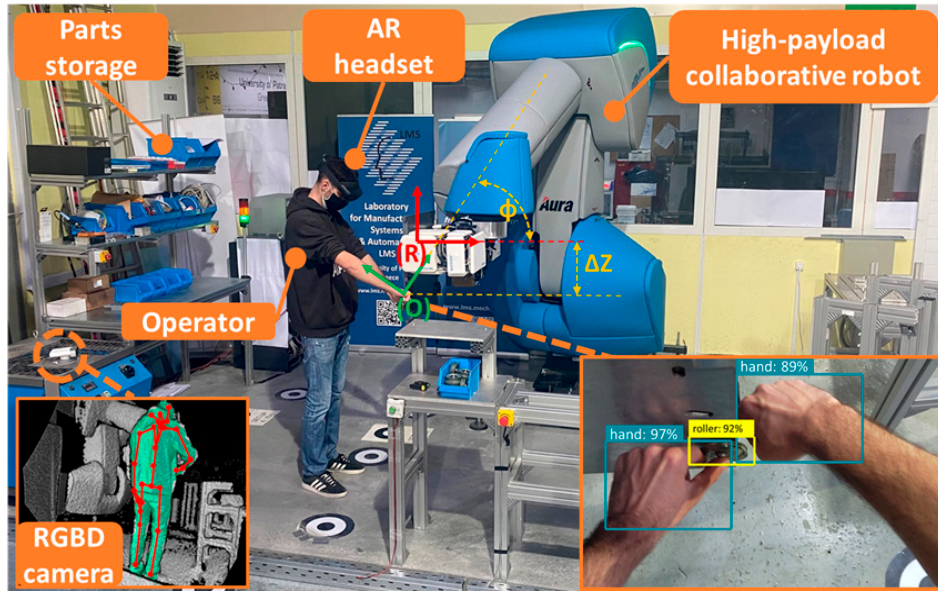
Figure 6. High-payload collaborative workstation paradigm. Table 1. Experimental results.